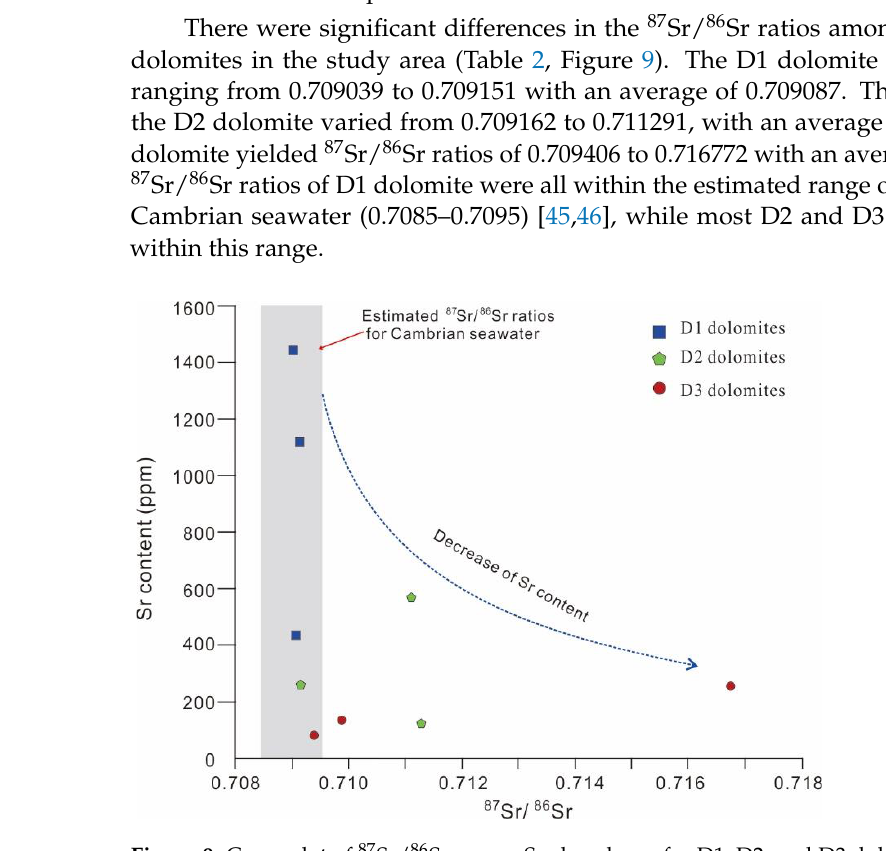
Table 3. Fluid inclusion data for D2 and D3 dolomites, and vein calcite from the Cambrian succes- sions in the Bachu area, Tarim Basin.